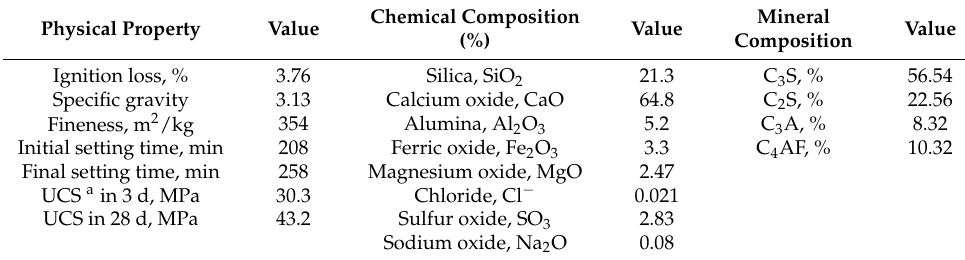
Table 2. Properties of cement utilized for this experiment.